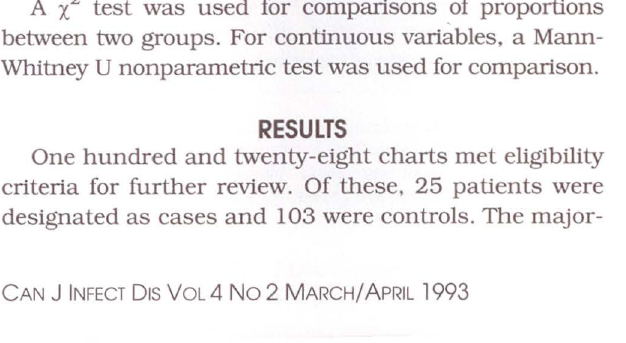
ity of cases had skin infections; 11 patients had celluli tis and four had impetigo, counting for 60o/o of infec tions. Other types of infection were septic arthritis (three patients). pharyngitis (two), lymphadenitis (one), osteomyelitis (one) and urinary tract infection (two). No patient had severe cellulitis or toxic shock-like syn drome. Control subjects included patients who had previously been healthy and those with underlying ill ness. The most common diagnoses were encephalitis (16 patients), febrile convulsions (five), preceding sei zure disorders (eight). idiopathic thrombocytopenic purpura (six). preceding diabetes mellitus (five), neo natal chickenpox (five) and Reye's syndrome (two). The median age (3.4 versus 4.9 years, respectively). dura tion of prior illness (four versus three days) and hospi talization (four days in both groups) was similar for cases and